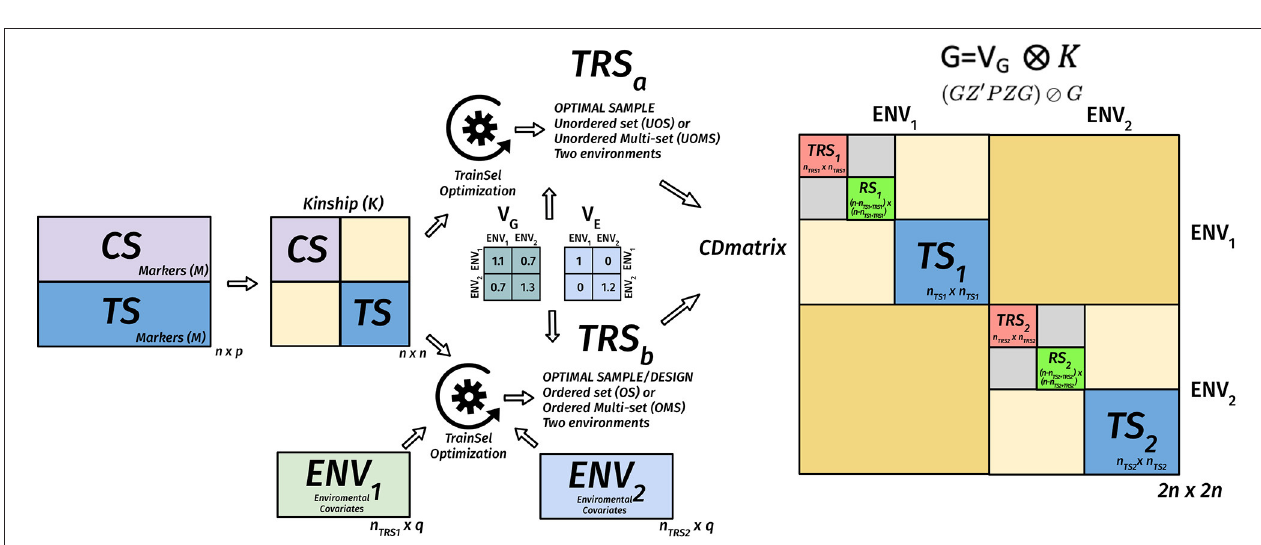
FIGURE 4 | Diagram of the matrix of the CD criterion in the TRS optimization for unordered and ordered experiments for the targeted case in a multi-environmental phenotypic experiment. We assume that we have n genotypes, n ts of them are in the target set (TS), the remaining of in the candidate set, n TRS selected to the TRS in environment 1, n TRS genotypes are selected to the TRS in environment 2. Two environments are assumed to have a positive genetic 2 covariance, and this is expressed in V k . The residual genetic covariance expressed in VE is diagonal, meaning that errors are uncorrelated between the two environments. These covariance matrices along with the genomic relationship matrix and if provided environmental covariates matrices for the environments are used to calculate the CD matrix (2 n × 2 n ) for a given design. The mean of the diagonals of this matrix that correspond to the TS is used as a criterion for evaluating different designs. The optimization algorithm tries to find the design that maximizes this